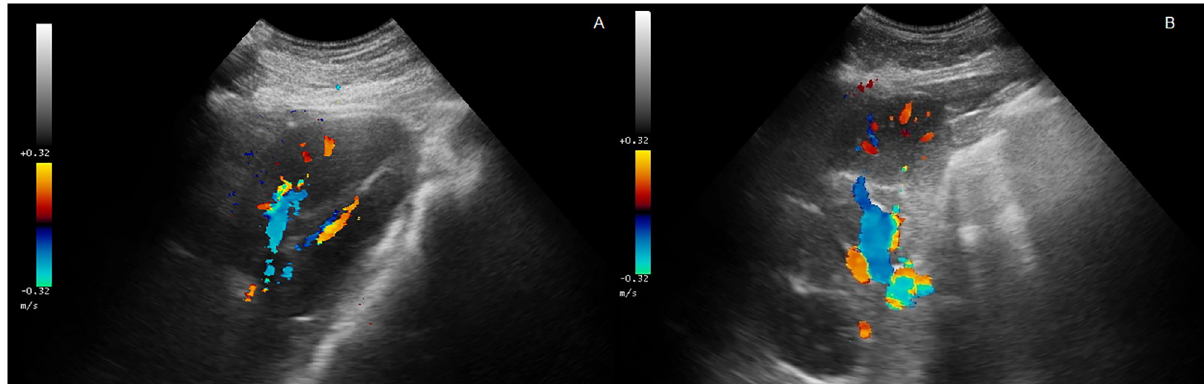
Fig 1. Colour Doppler ultrasound image showing the intrarenal vessels in the right kidney of a foal (A) and an adult horse (B).